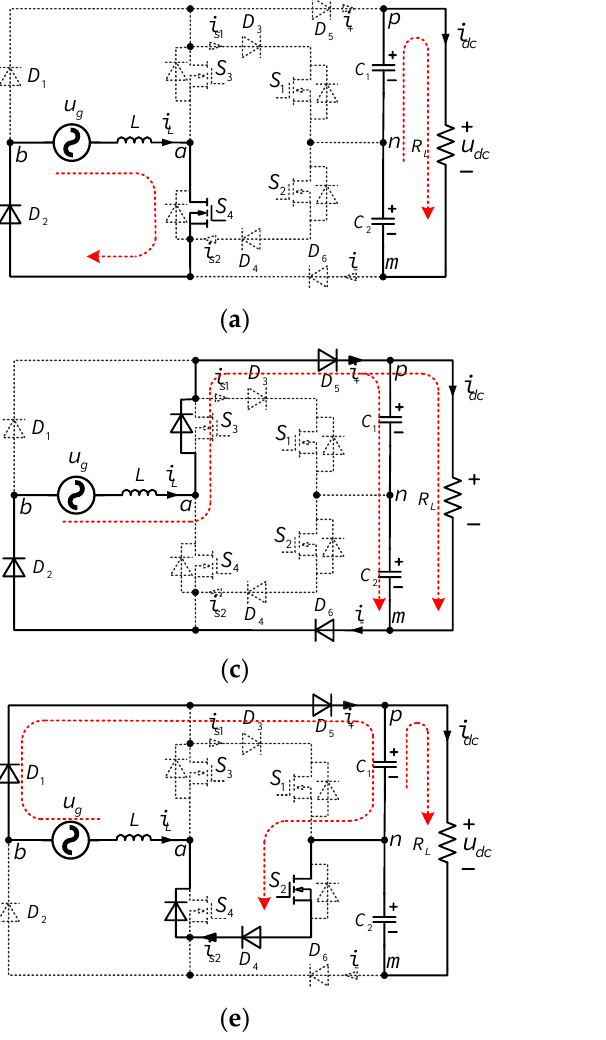
t Figure 5. Key operating waveforms of the STL-PFC in theory.